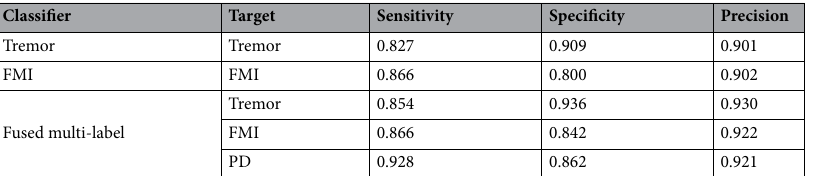
Table 2. Classification performance for the LOSO experiment on the SData set. For each predicted label (tremor, FMI and PD) we report the average sensitivity, specificity and precision across 10 independent experimental trials. The first two rows present the predictive performance of standalone symptom classifiers. Such models arise during the initial pre-training step, when the separate branches that comprise the total model are separately trained against a single symptom label (the pre-training procedure is described in detail in Section Training details). The rest of the table, presents the performance of the fused multi-label